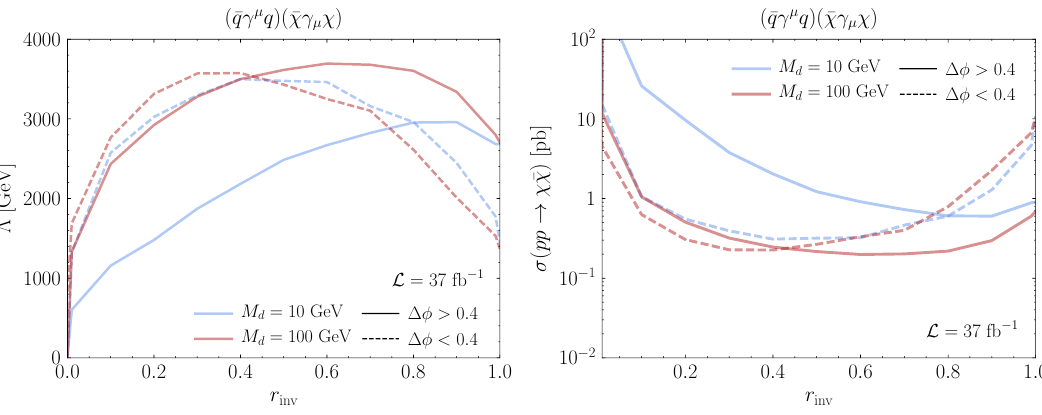
Figure 7 . Projected sensitivity on the scale for the vector contact operator (left) and its associated production cross section (right) for dark hadron masses M d = 10 and 100 GeV (blue and red, respectively). The limits are shown for (cid:1) (cid:30) < 0 : 4 GeV (dashed) and (cid:1) (cid:30) > 0 : 4 GeV (solid).